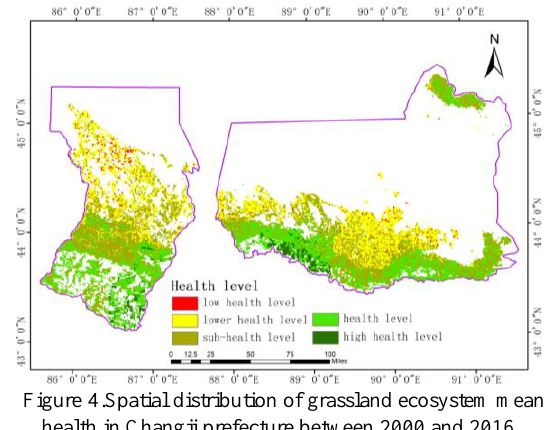
Figure 4.Spatial distribution of grassland ecosystem mean health in Changji prefecture between 2000 and